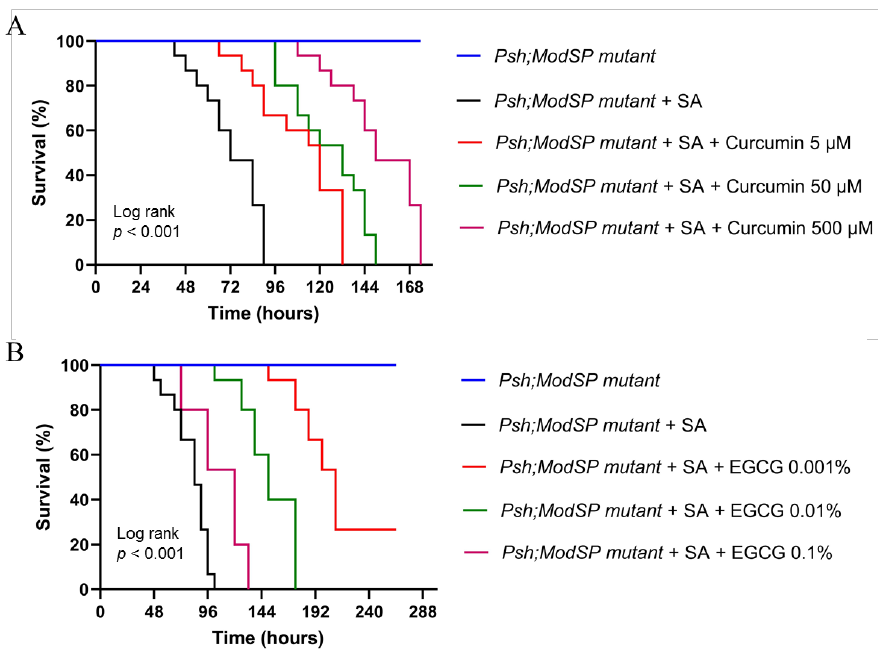
Figure 3. The lifespan of adult males of psh[1];;modSP[KO] in the presence or absence of curcumin ( A ) or EGCG ( B ) under bacterial challenge. For each survival experiment, adult males of psh[1];;modSP[KO] at 4–7 days old were infected with S. aureus and maintained at 29 ◦ C in fly food containing the respective drug/active compounds. The numbers of surviving and dead flies were recorded daily, and fly survivorship was analyzed using a Kaplan–Meier Log Rank approach. EGCG; epigallocatechin gallate, SA; Staphylococcus aureus.